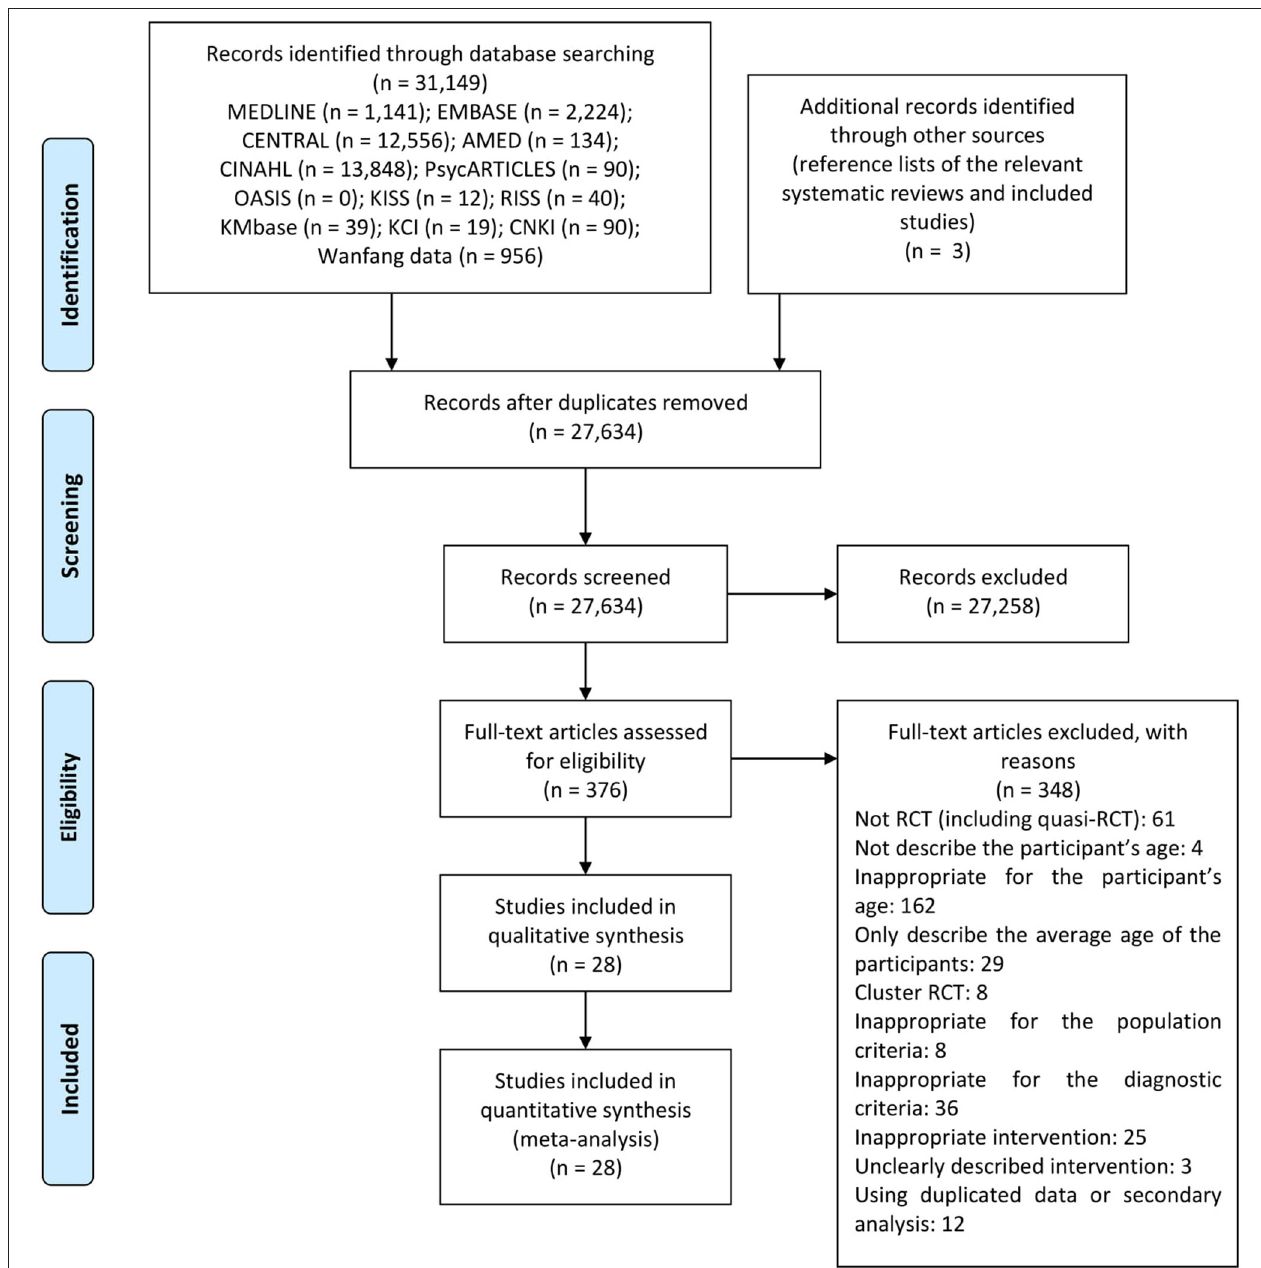
FIGURE 1 | PRISMA flow chart. AMED, the allied and complementary medicine database; CENTRAL, the Cochrane central register of controlled trials; CINAHL, the cumulative index to nursing and allied health literature; CNKI, China national knowledge infrastructure; KCI, Korea citation index; KISS, Koreanstudies Information Service System; KMbase, Korean medical database; OASIS, Oriental medicine advanced searching integrated system; RCT, randomized controlled trial; RISS, research information service